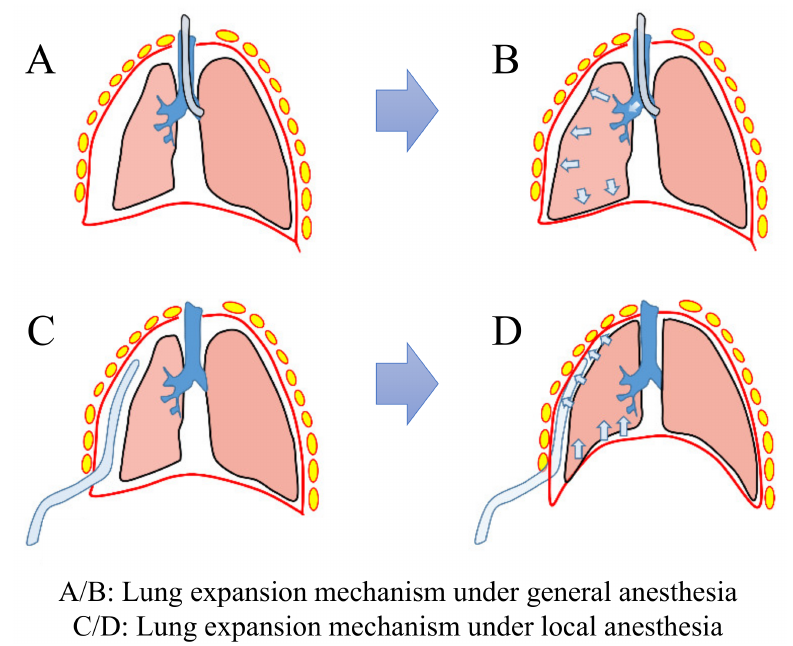
Figure 1. Diagram illustrating the biomechanical behavior of lung according to the anesthetic technique